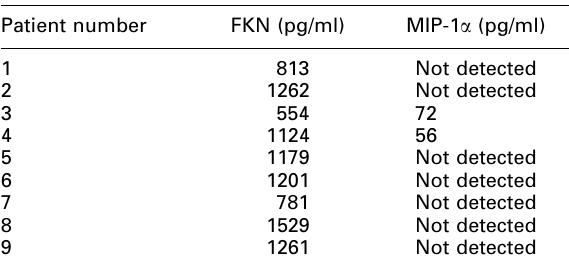
Table 1. Serum levels of FKN and MIP-1 a in patients affected by MSD Patient